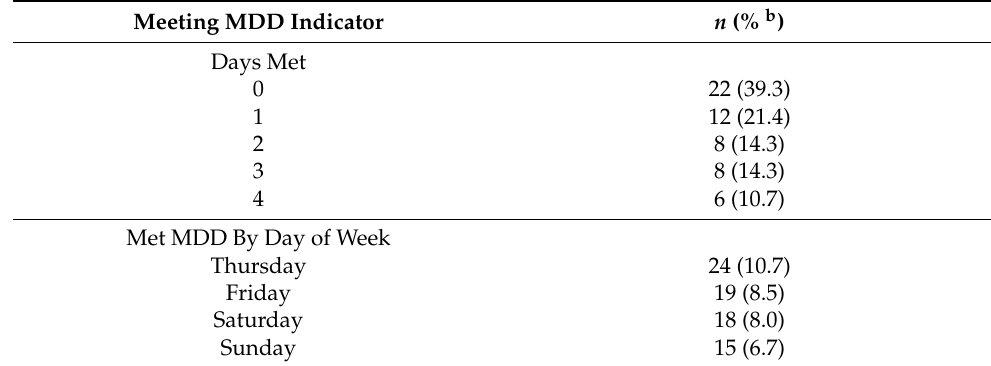
Table 3. Frequency of number of days infants, ages 6–12 months ( n = 56), met the Minimum Diet Diversity (MDD) a and by day of